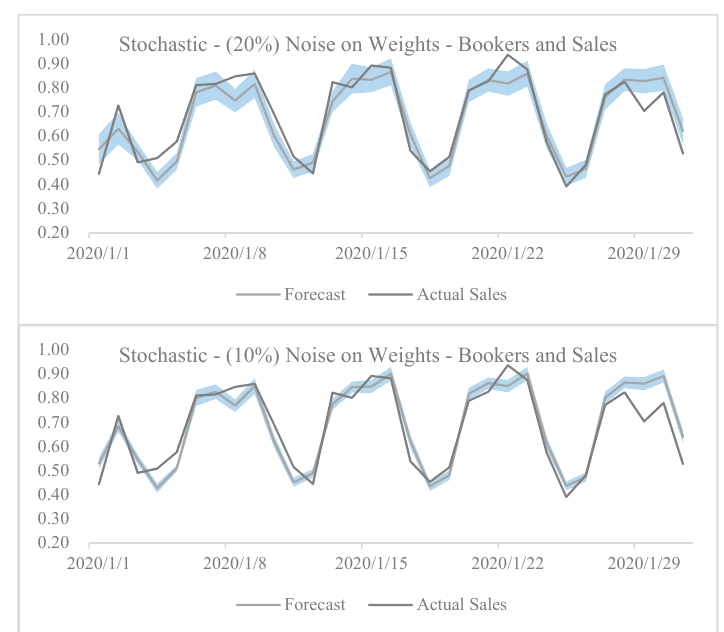
Figure 5. Actual vs. predicted January sales for various cases: deterministic model; stochastic—normal noise with active booker count and sales uncertainty; stochastic—dropout with active booker count and sales uncertainty; Stochastic—noise on weights—active booker count and sales. The details of active booker count only stochastic models, and sales only stochastic models are shown in the Appendices A and B. The shaded area represents the range of stochastic variance (uncertainty) in the model predictions.